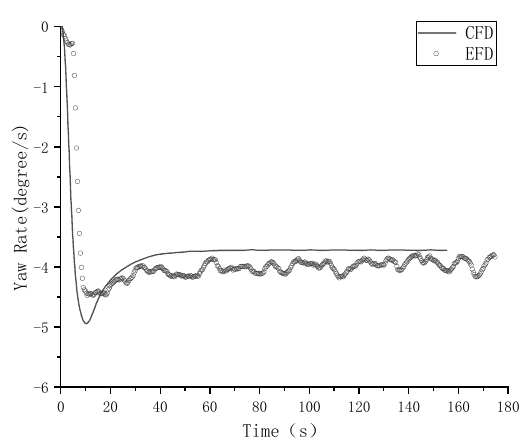
Figure 10. Comparison of +35° yaw rates.